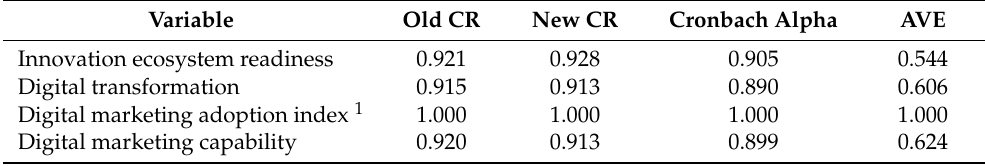
Table 3. Old and new composite reliability value.